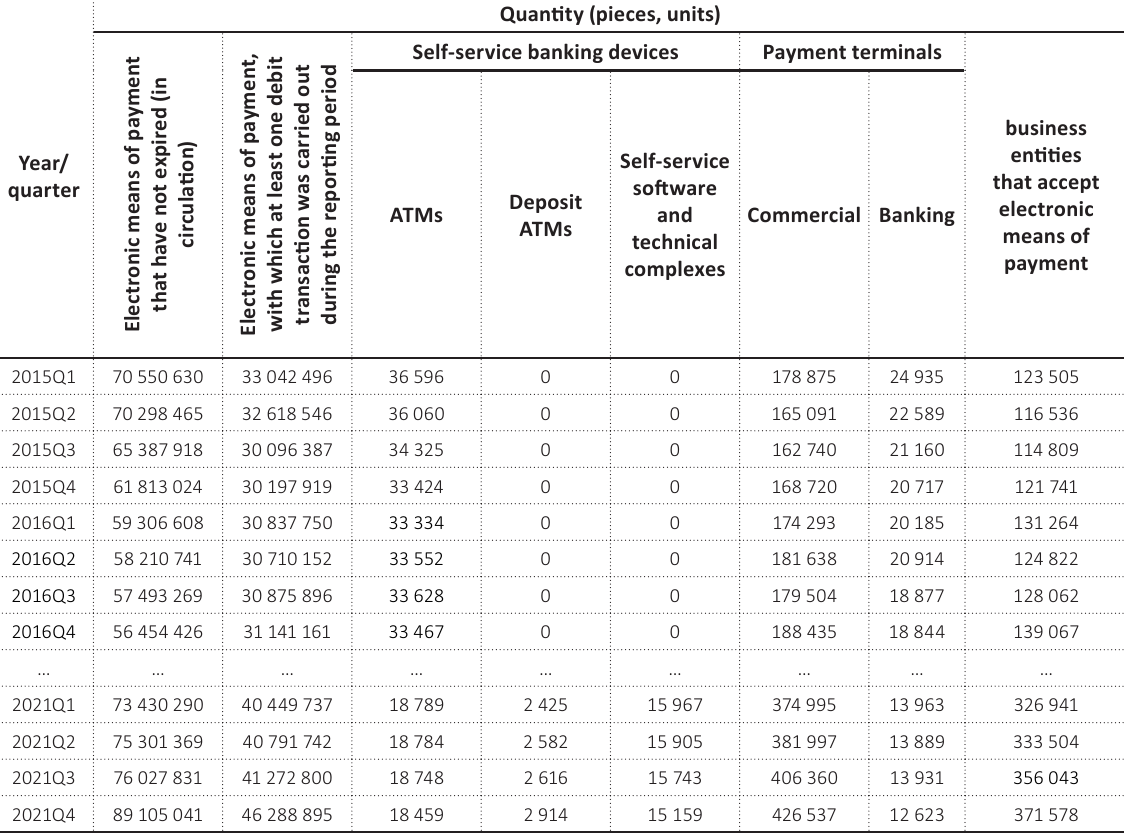
Table А11. Information base for the study of digitization’s specific indicators Quantity (pieces,